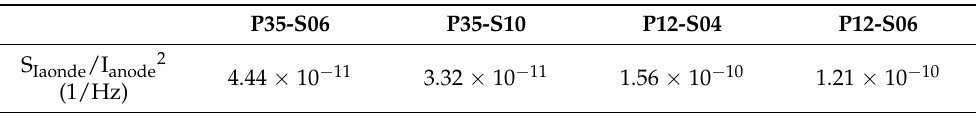
Figure 7. Noise characteristics normalized with I anodes of the four types of a-Si microbolometers: ( a ) P35-S06, ( b ) P35-S10, ( c ) P12-S04, and ( d ) P12-S06. Table 3. Comparison of values at the midpoint (50%) of the cumulative curves plotted in Figure 8 of the four types of a-Si